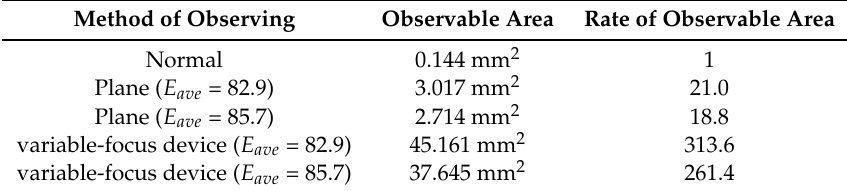
Table 1. Comparison of observable